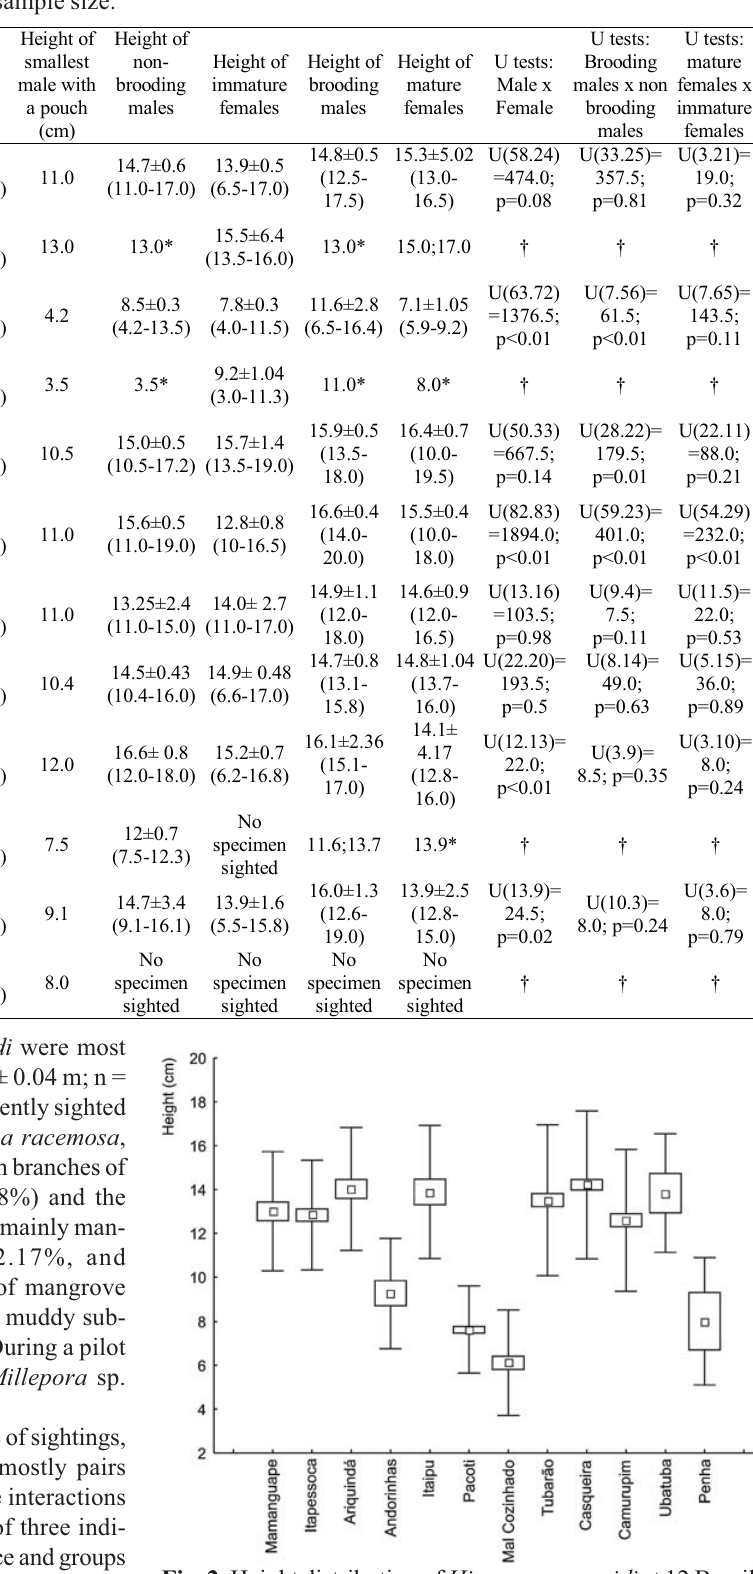
Fig. 2. Height distribution of Hippocampus reidi at 12 Brazil- ian localities. Mean, ± SE, ±